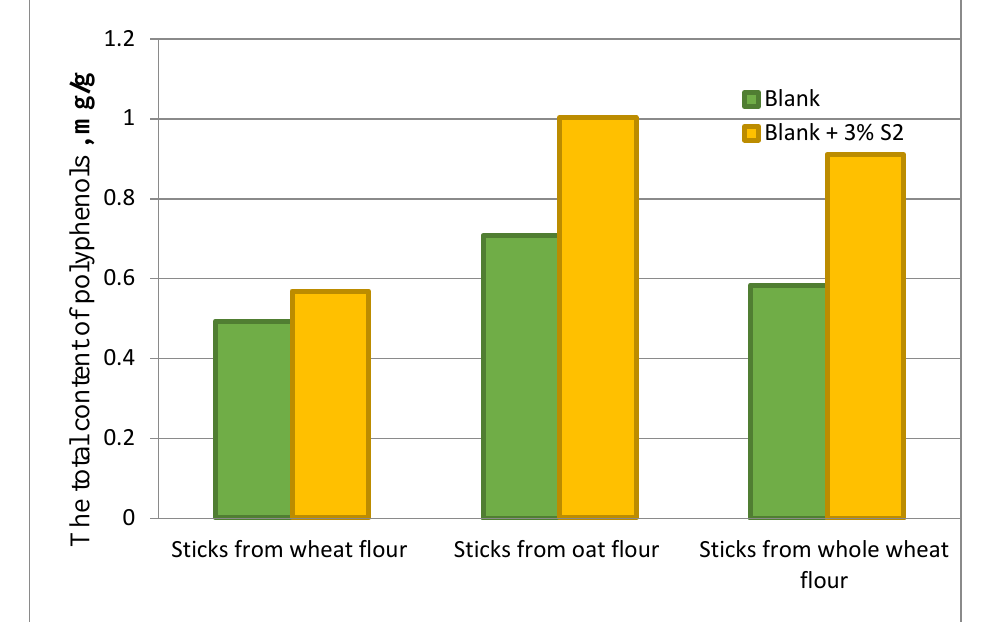
Figure 2. The variation of the total content of polyphenols in sticks.